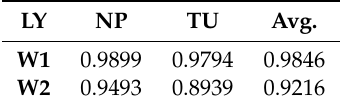
Figure 14. W2’s confusion matrices for the output of the conv VGG corresponding to each group: ( a ) lying; ( b ) sedentary; ( c ) standing; ( d ) walking. Table 6. F 1 accuracy of the lying group (LY).